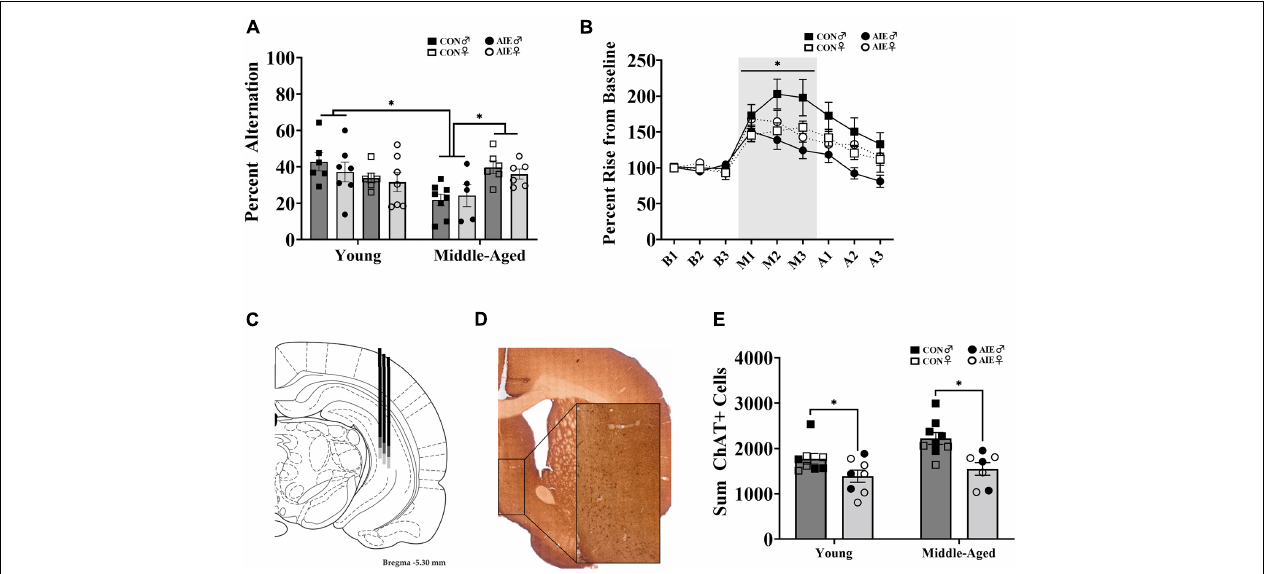
FIGURE 2 | Sex differences on spatial working memory task. (A) Spontaneous alternation behavior. Young rats (AIE: Male = 7; Female = 7; CON: Male = 6; Female = 6) did not differ between sex or exposure ( p = 0.15), but middle-aged males (CON = 8; AIE = 5) performed worse ( ∗ p = 0.001) than middle-aged females (CON = 6; AIE = 6). Middle-aged males also performed worse than young adult males ( ∗ p = 0.001), an effect not seen in females ( p = 0.18). (B) Percent rise from baseline ACh levels in the hippocampus during spontaneous alternation testing. Data from young and middle-aged time points are combined in order to show Exposure × Sex × Phase interaction. Control male rats ( n = 13) had a higher rise from baseline during testing than control females (* p = 0.005; n = 12), male AIE-exposed rats ( p < 0.001; n = 12), and female AIE-exposed rats ( p = 0.03, n = 12). (C) Examples of hippocampal microdialysis probe placement (AP = –5.3 mm, ML = 5.1 mm, DV = –5.2 mm) during spontaneous alternation is depicted by the solid dark gray line. Microdialysis probe placement (AP = –5.3 mm, ML = 5.1 mm, DV = –7.2 mm) during NOP is depicted by the lighter gray extension of the solid line. Image from Paxinos and Watson (2014). (D) Image of ChAT+ cells in the MS/DB (AP: 0.72 mm). Cells were quantified in one hemisphere on every 5th 40 µ m section of the MS/DB. (E) AIE results in the suppression (27%) of cholinergic tone in the MS/DB ( p < 0.001). Due to the quality of tissue, some samples were not included in cell quantification and sex differences were not able to be determined. For final ChAT+ counts: Young control males ( n = 4), young control females ( n = 5), young AIE males ( n = 3), young AIE females ( n = 5), middle-aged control males ( n = 6), middle-aged control females ( n = 3), middle-aged AIE males ( n = 3), middle-aged AIE females ( n =